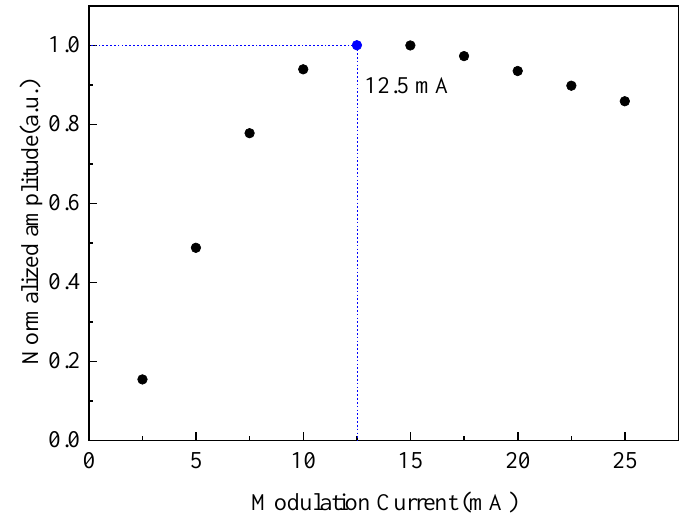
Figure 5. QEPAS signal as a function of modulation